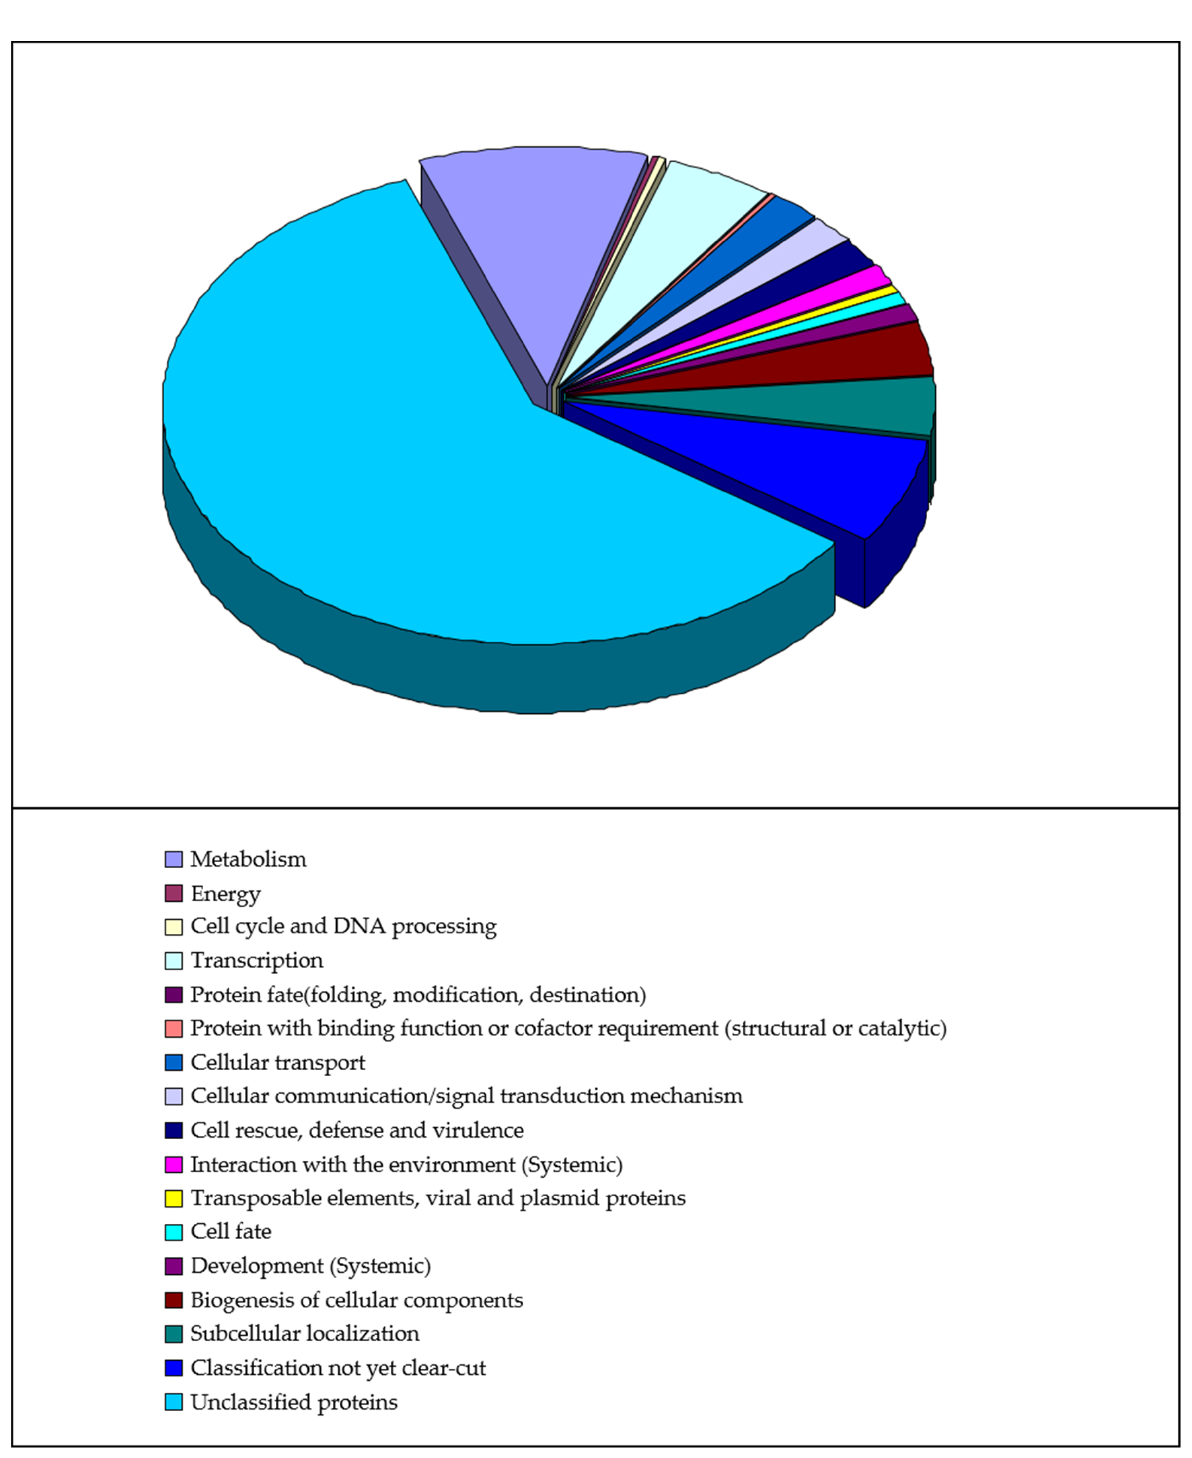
Figure 2. General biological process categorization on putative auxin-responsive genes. The sets of putative genes predicted in our study were analysed with the use of the MIPS from http://mips.gsf.de/ (accessed on 10 November 2021).